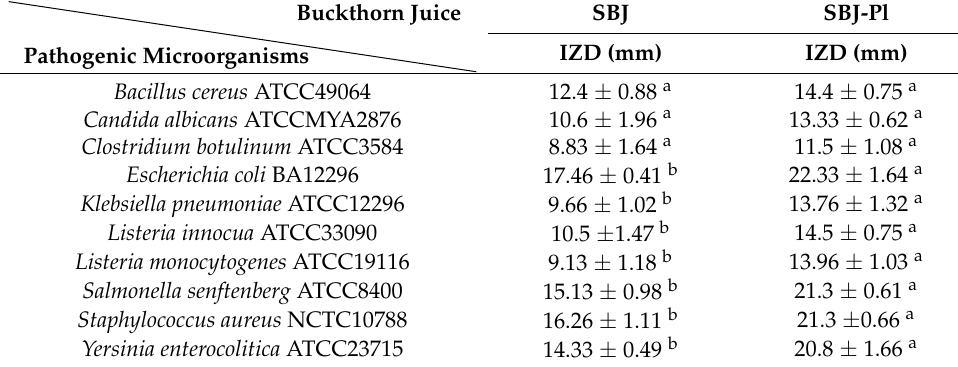
Figure 4. Antioxidant activity of fermented and non-fermented sea buckthorn juice. ( A ) DPPH methods; ( B ) ABTS methods. SBJ, sea buckthorn juice; SBJ-Pl, sea buckthorn juice fermented with Lactobacillus plantarum. Table 5. Antimicrobial activity of sea buckthorn